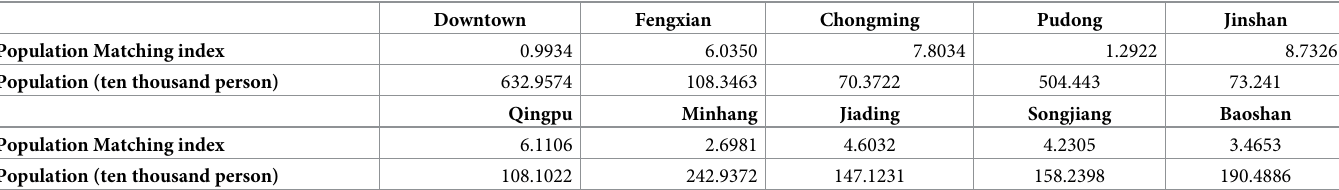
Table 4. Population matching index and